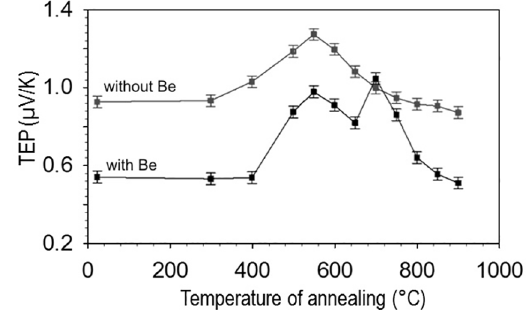
Figure 3. TEP as a function of annealing temperature for the alloy "without" (grey) and "with" (black) beryllium However, TEP also reveals that a second precipitation containing alloy, by annealing at 700ºC. The BF